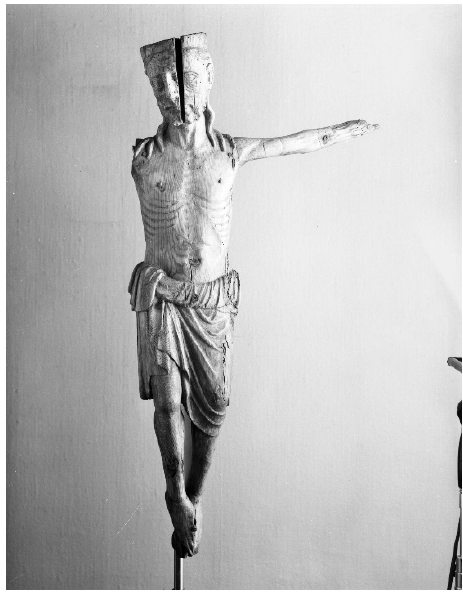
Figure 4. Crucifix from Sandeid. Polychrome birch, 1225–1250. Bergen, University Museum. Photo: Ørnulf Hjort-Sørensen (CC BY-SA 4.0).